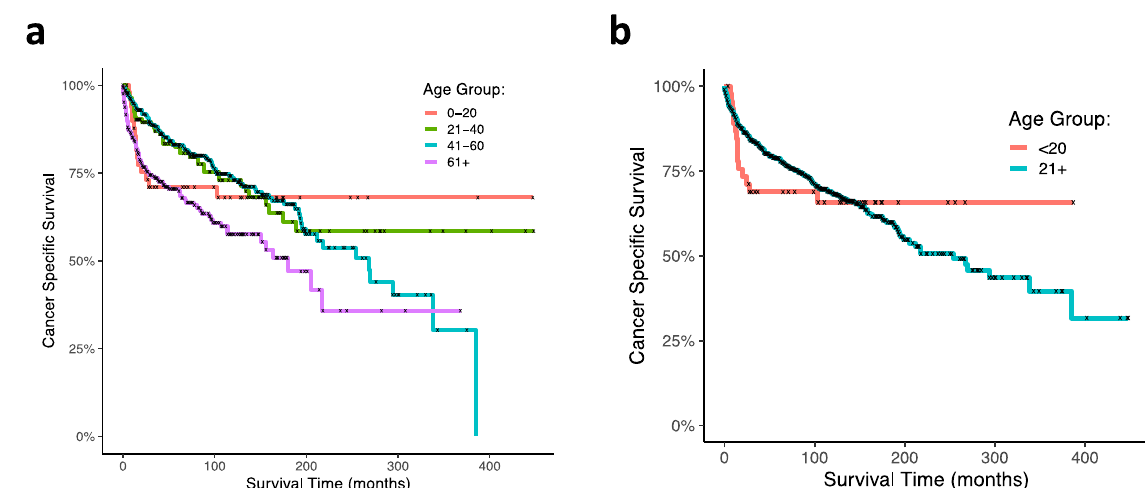
Table 1. Generalized linear model statistics demonstrating CSS interactions between ONB disease severity (tumor stage, grade, and lymph node involvement) and chemotherapy, radiation and surgery or patient age at diagnosis.